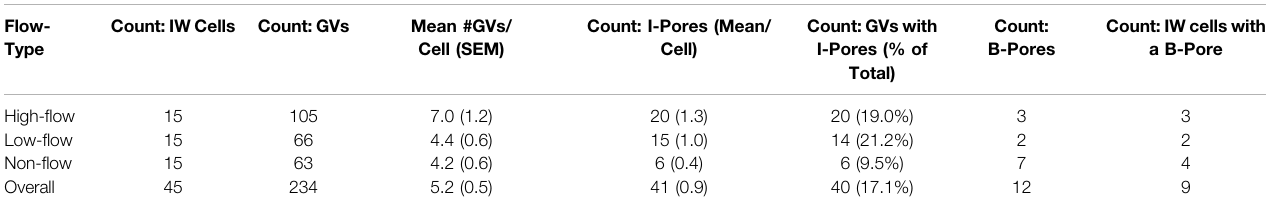
TABLE 1 | Summary of giant vacuoles and pores of reconstructed IW cells. Flow-